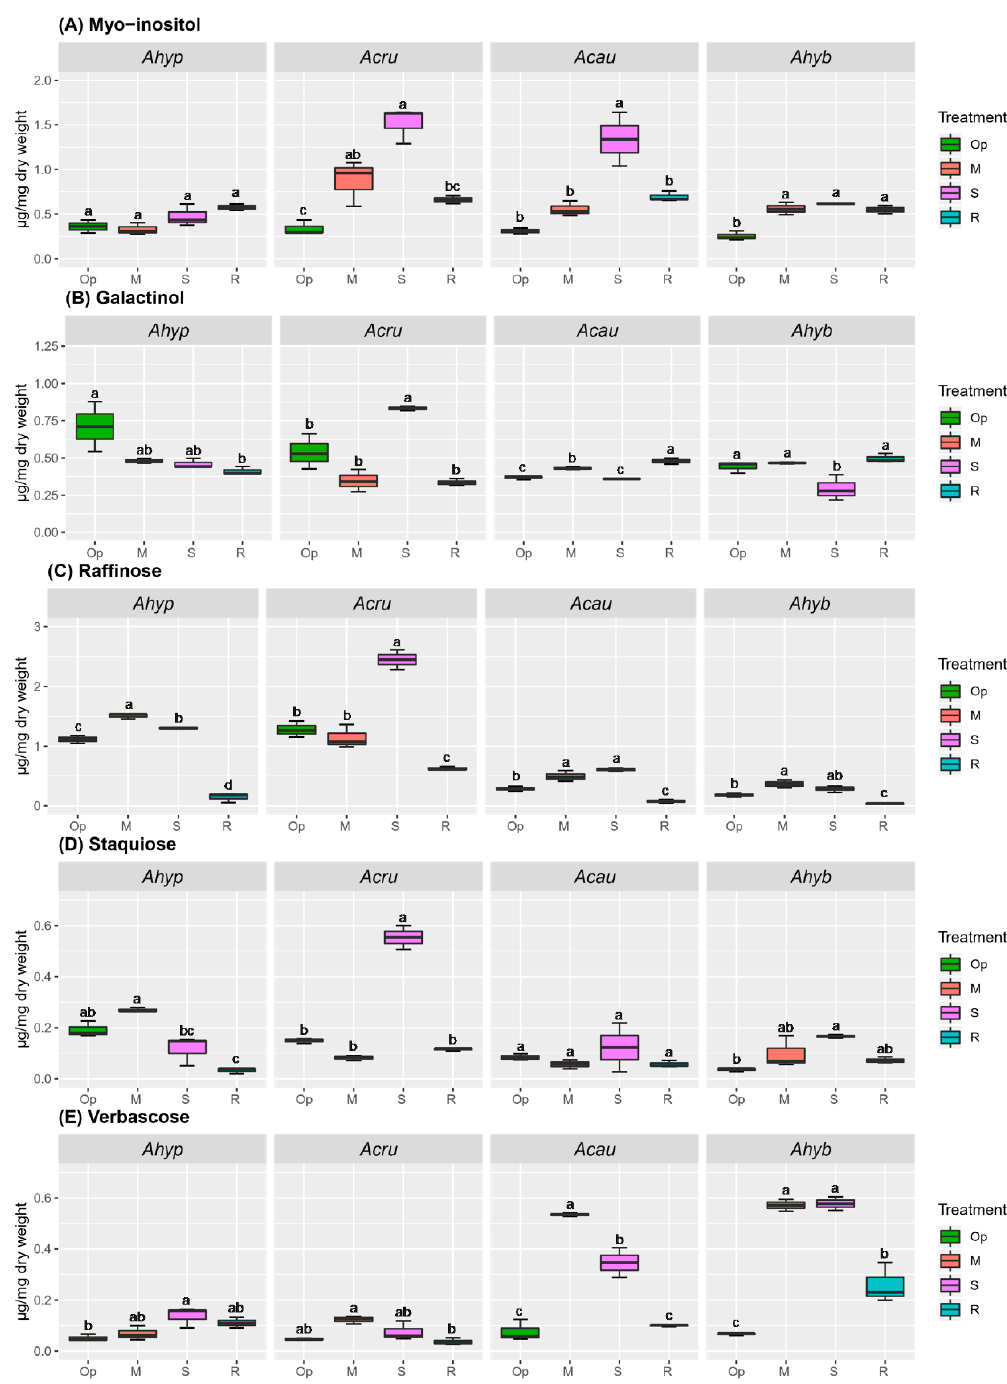
Figure 7. Raffinose family oligosaccharides (RFOs) in leaves of amaranth plants subjected to water-deficit stress. RFOs in leaves of Amaranthus hypochondriacus (Ahypo), A. cruentus (Acru), A. caudatus (Acau), and A. hybridus (Ahyb) plants growing in optimal conditions (Op), subjected to moderate (M) or severe (S) water deficit stress, or allowed to recover from S, 1 day after normal watering was restored (R). RFOs and RFO precursors analyzed were: ( A ) Myo-inositol; ( B ) galactinol; ( C ) raffinose; ( D ) staquiose; and ( E ) verbascose. Different letters over the box-and-whisker plots represent statistically significant differences at p ≤ 0.05 (Tukey Kramer test; n = 9). Box-and-whisker plots show high, low, and median values. The results shown are those obtained from a representative experiment that was repeated in the spring-summer and summer-autumn seasons of 2015, respectively, with similar results.